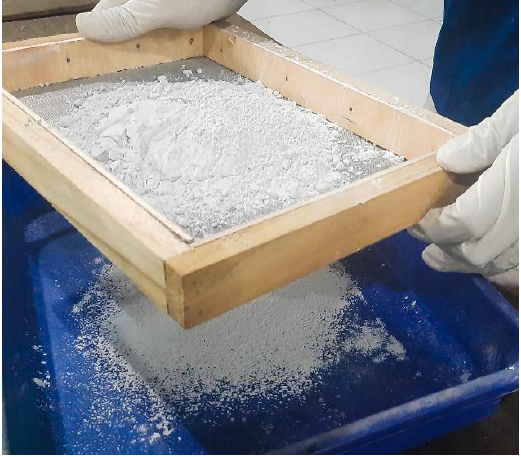
Figure 2. Filtering ground glass with a filter with a mesh size of 200.